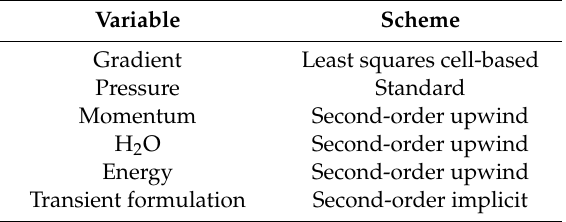
Table 2. Solution methods